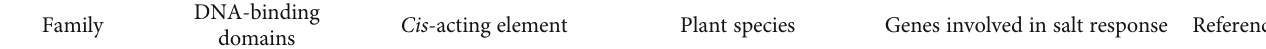
Table 1: List of transcription factors associated with